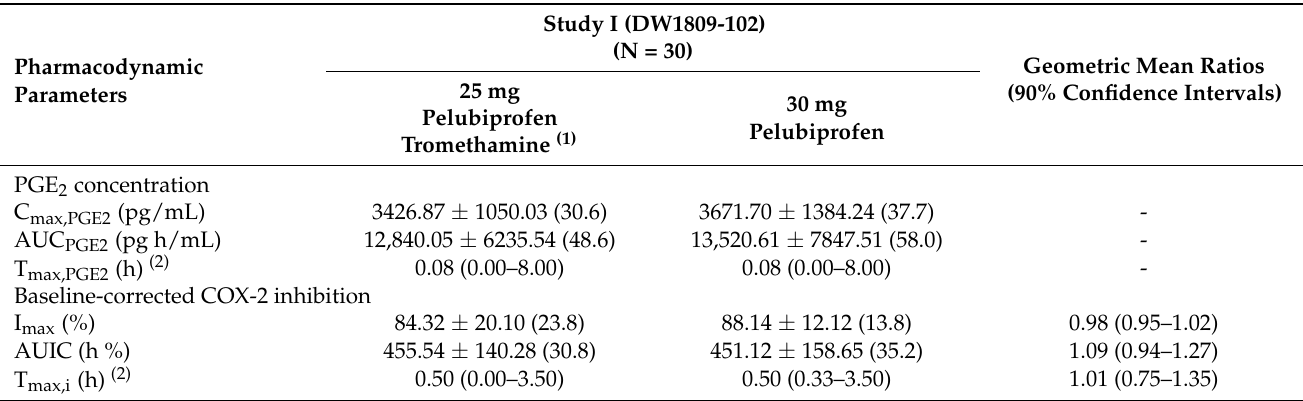
Table 4. The COX-2 inhibition derived from PGE 2 concentration after administration of 25 mg of pelubiprofen tromethamine and 30 mg of